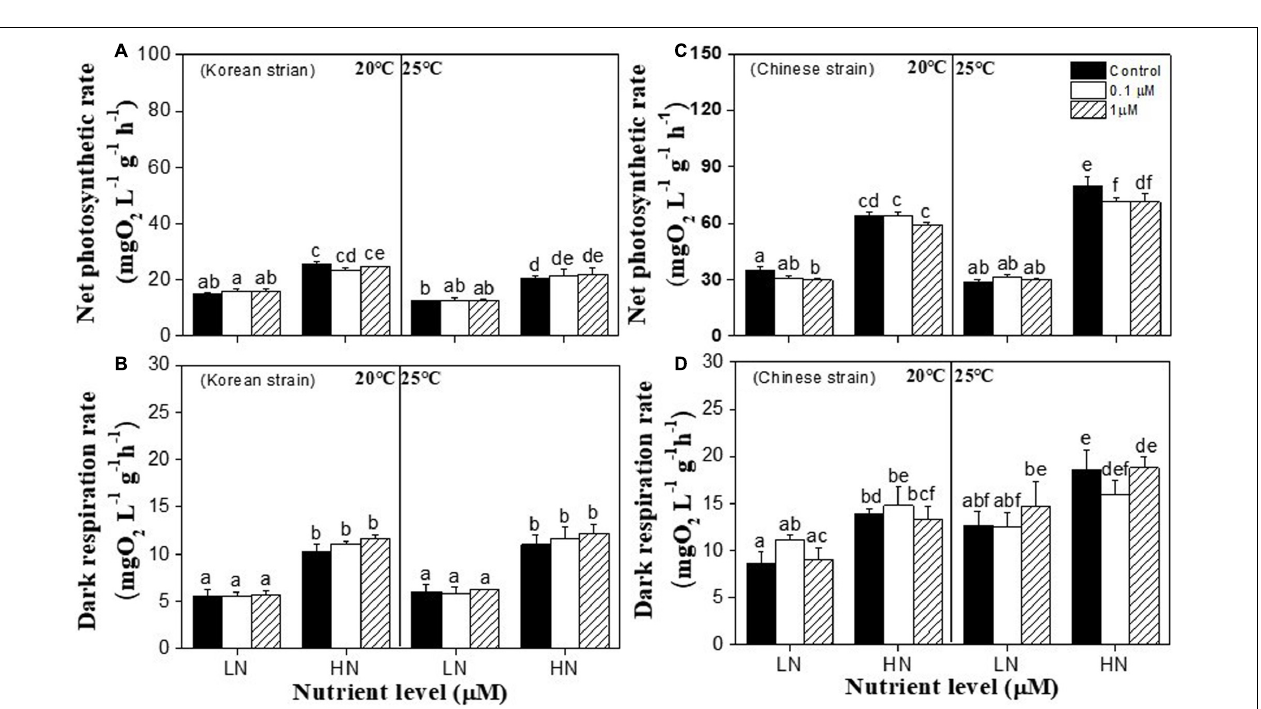
FIGURE 1 | Relative growth rate (RGR) in a Korean strain (A) and Chinese strain (B) of Ulva prolifera cultivated under various experimental conditions. The error bars represent the standard deviation ( n = 3). Low nutrient = 50 µ M nitrate and 5 µ M phosphate (LN); high nutrient = 250 µ M nitrate and 25 µ M phosphate (HN). Different letters above the error bars represent statistical significance ( P < 0.05) among different treatments.